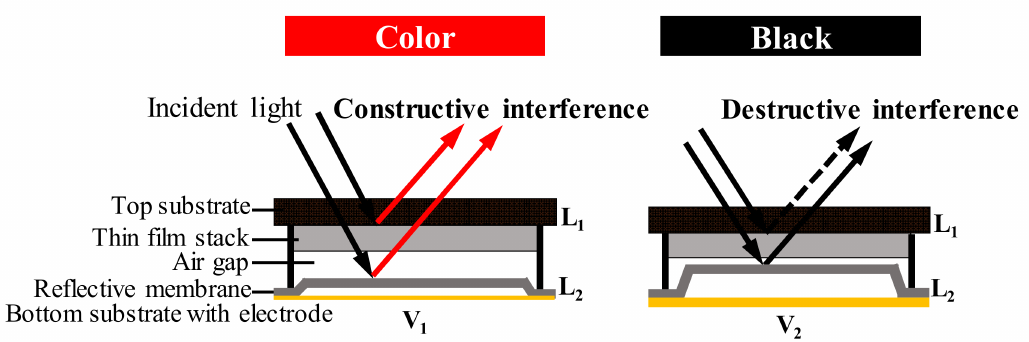
Figure 4. Device structure and working principle of the interferometric modulator display